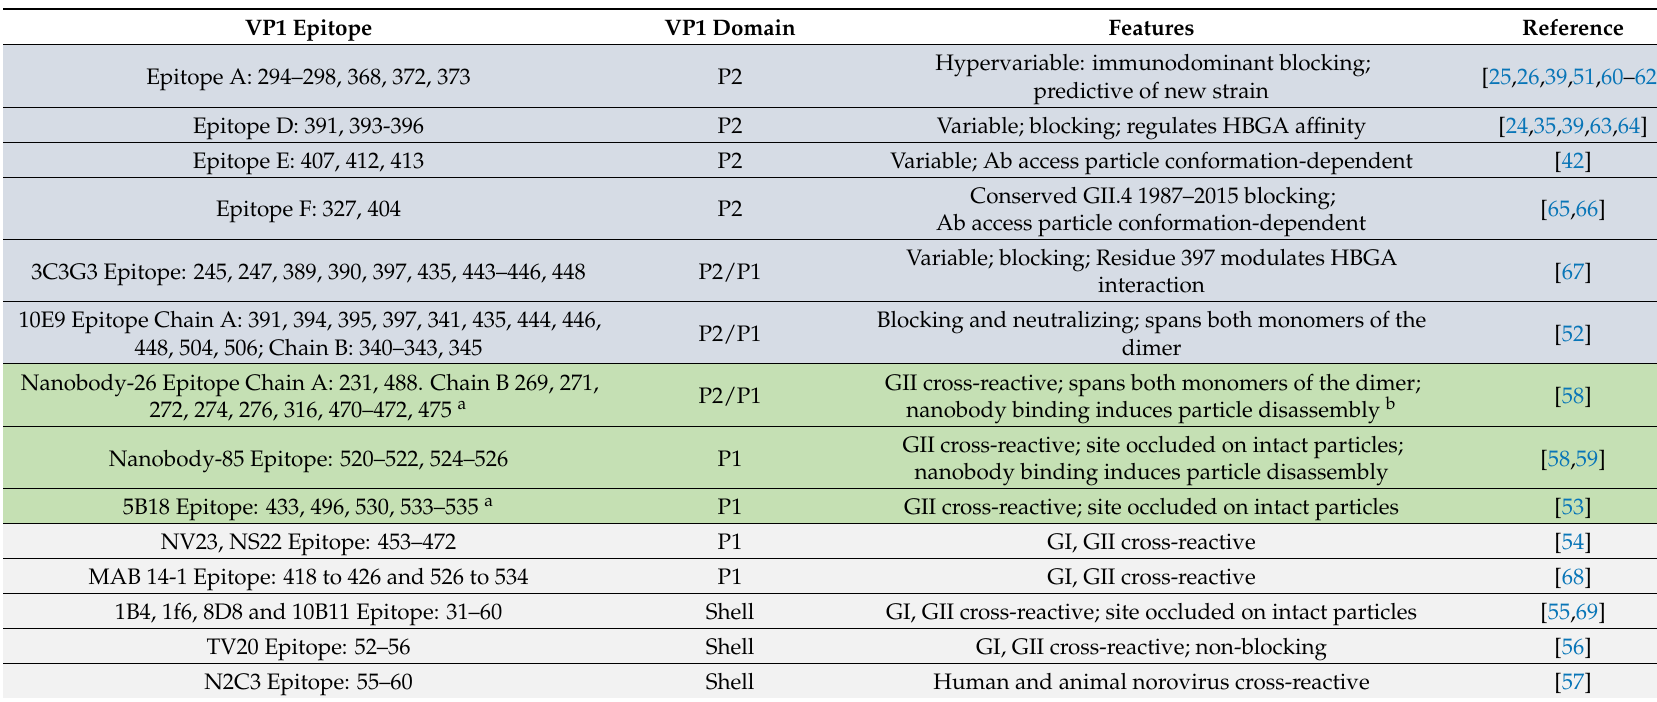
Table 1. GII.4 human norovirus antibody epitopes. GII.4 monoclonal antibodies (mAbs) bind to GII.4-specific blockade epitopes located in the P2 subdomain (blue shading), GII cross-reactive epitopes located in the P1/P2 domains (green), or GI/GII cross-reactive regions located primarily in the shell domain (grey) and